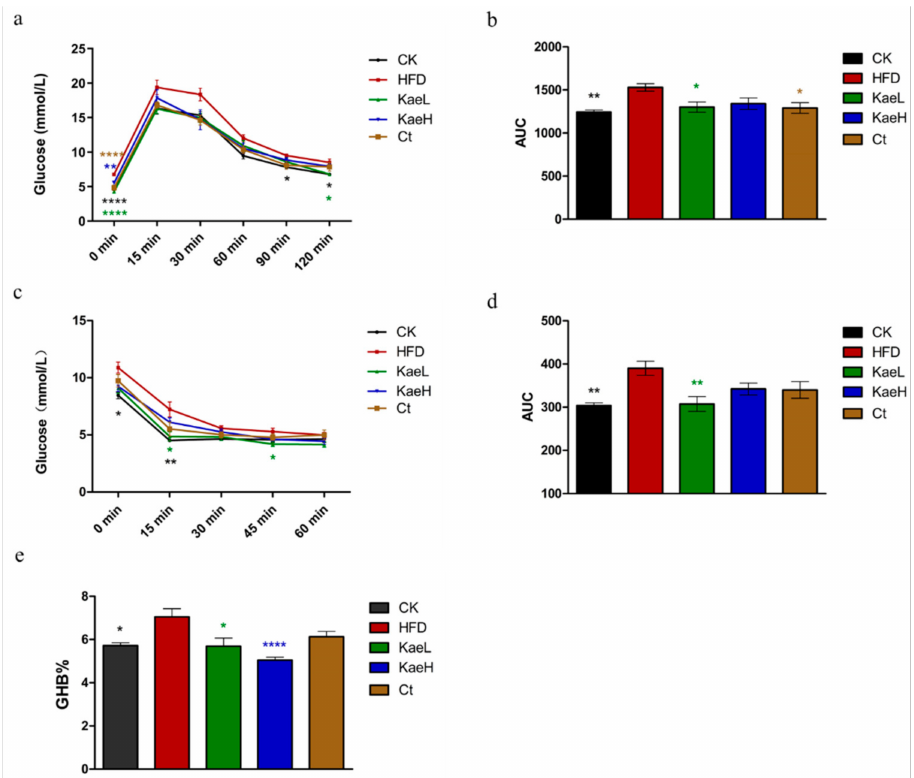
Figure 2. Effects of C. tinctoria and kaempferol on glucose metabolism in DIO mice. ( a ) Glucose tolerance test (GTT). ( b ) The area under the curve (AUC) of GTT. ( c ) Insulin tolerance test (ITT). ( d ) The AUC of ITT. ( e ) Hemoglobin a1c (HbA1c) concentrations of whole blood. GHB: glycated hemoglobin, CK: control group, HFD: high-fat diet group, Ct: HFD+water extract of C. tinctoria group, KaeL: HFD+kaempferol low group, KaeH: HFD+kaempferol high group. Value = mean ± SD (n = 8). * p < 0.05 vs. HFD, ** p < 0.01 vs. HFD, **** p < 0.0001 vs.